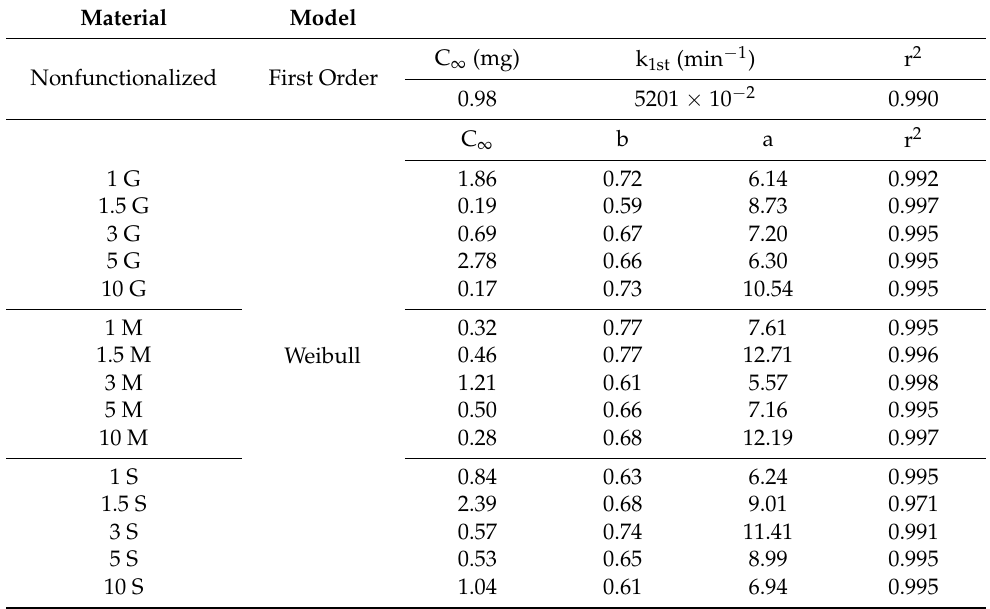
Table 3. Fitting constants and model applied to the drug release curves of the mesoporous materials.